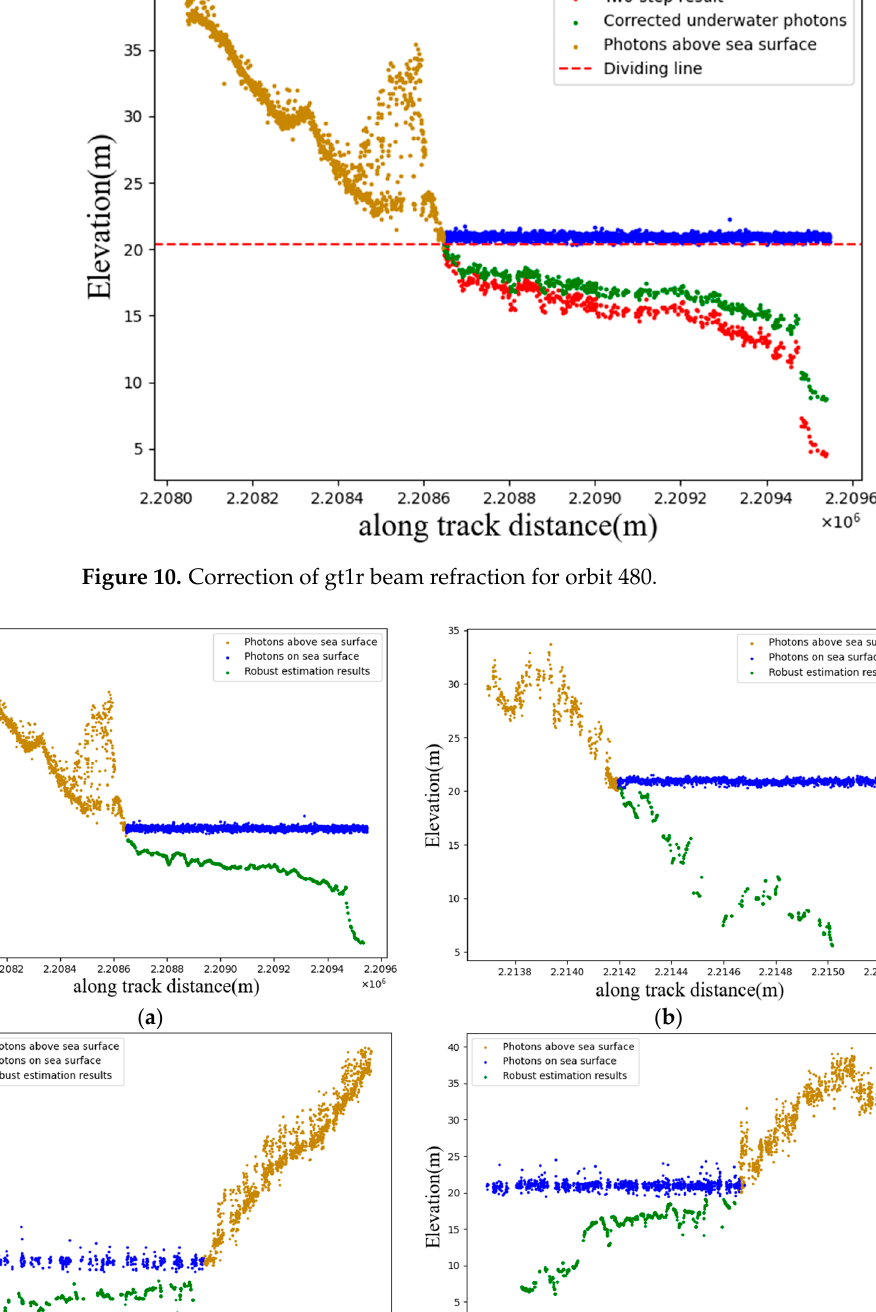
( d ) Figure 9. ( a ) The two-step method denoised 480 orbit gt1r beam; ( b ) the two-step method denoised 480 orbit gt2r beam; ( c ) the two-step method denoised 1036 orbit gt2r beam; ( d ) the two-step method denoised 1036 orbit gt1r beam. 4.4. Draw Bathymetry Pro fi les As seen in Figure 10, after photon denoising, the refraction correction of the de-